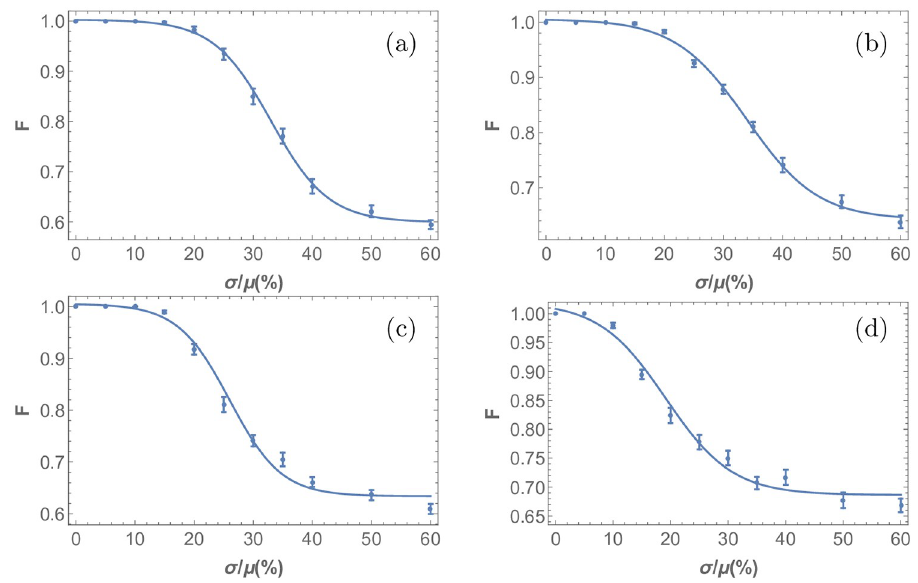
Fig 10. Universal threshold response to stochasticity in different model parameters. In each sub-plot, stochasticity is introduced in the following parameters of the underlying differential equations: (a) D u and D s , (b) P a , (c) S , and (d) G . Introduction of parametric noise in all of the former parameters, produces a sigmoid response. The order measure used is the fidelity of the nearest neighbor distance probability distributions and sigmoid curves were used to fit the